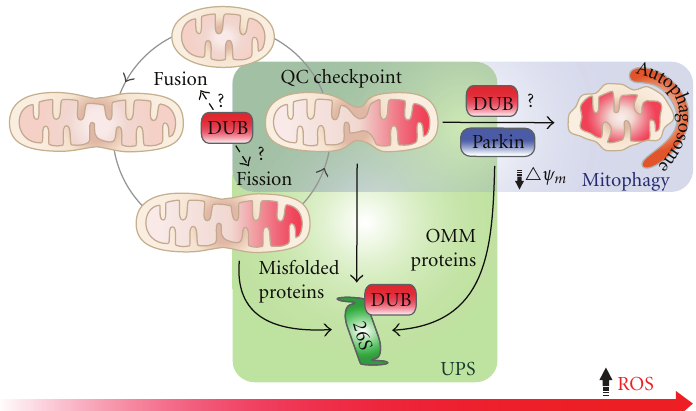
Figure 5: Mitochondrial quality control systems. Mitochondria are dynamic organelles that continually undergo membrane fission and fusion events to maintain their integrity. Under mild to moderate stress, fission facilitates the segregation of damaged areas of the mitochondrial network, while fusion dilutes damaged elements by combining mitochondrial pools. When the damage is extensive, mitochondria are removed by mitophagy. In addition, there is increasing evidence indicating that the UPS participates in the turnover of several OMM and non-OMM proteins. Ubiquitin has been shown to be a key regulator of membrane dynamics and mitophagy. Hence, it is likely that DUBs also participate at various stages within these mitochondrial quality control pathways, in order to maintain a steady equilibrium of protein